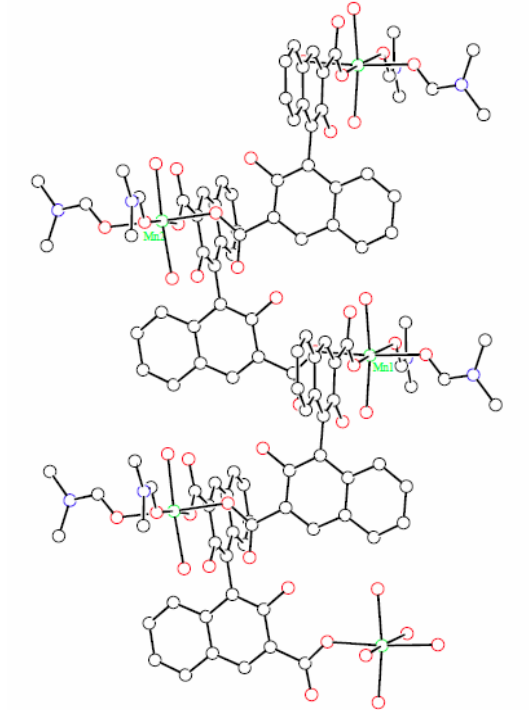
Figure 4. Right-handed helical structure in the crystal of ( R )-MOF- 2 . The a -axis of the crystal is oriented vertically. All hydrogen atoms and guest molecules are omitted for